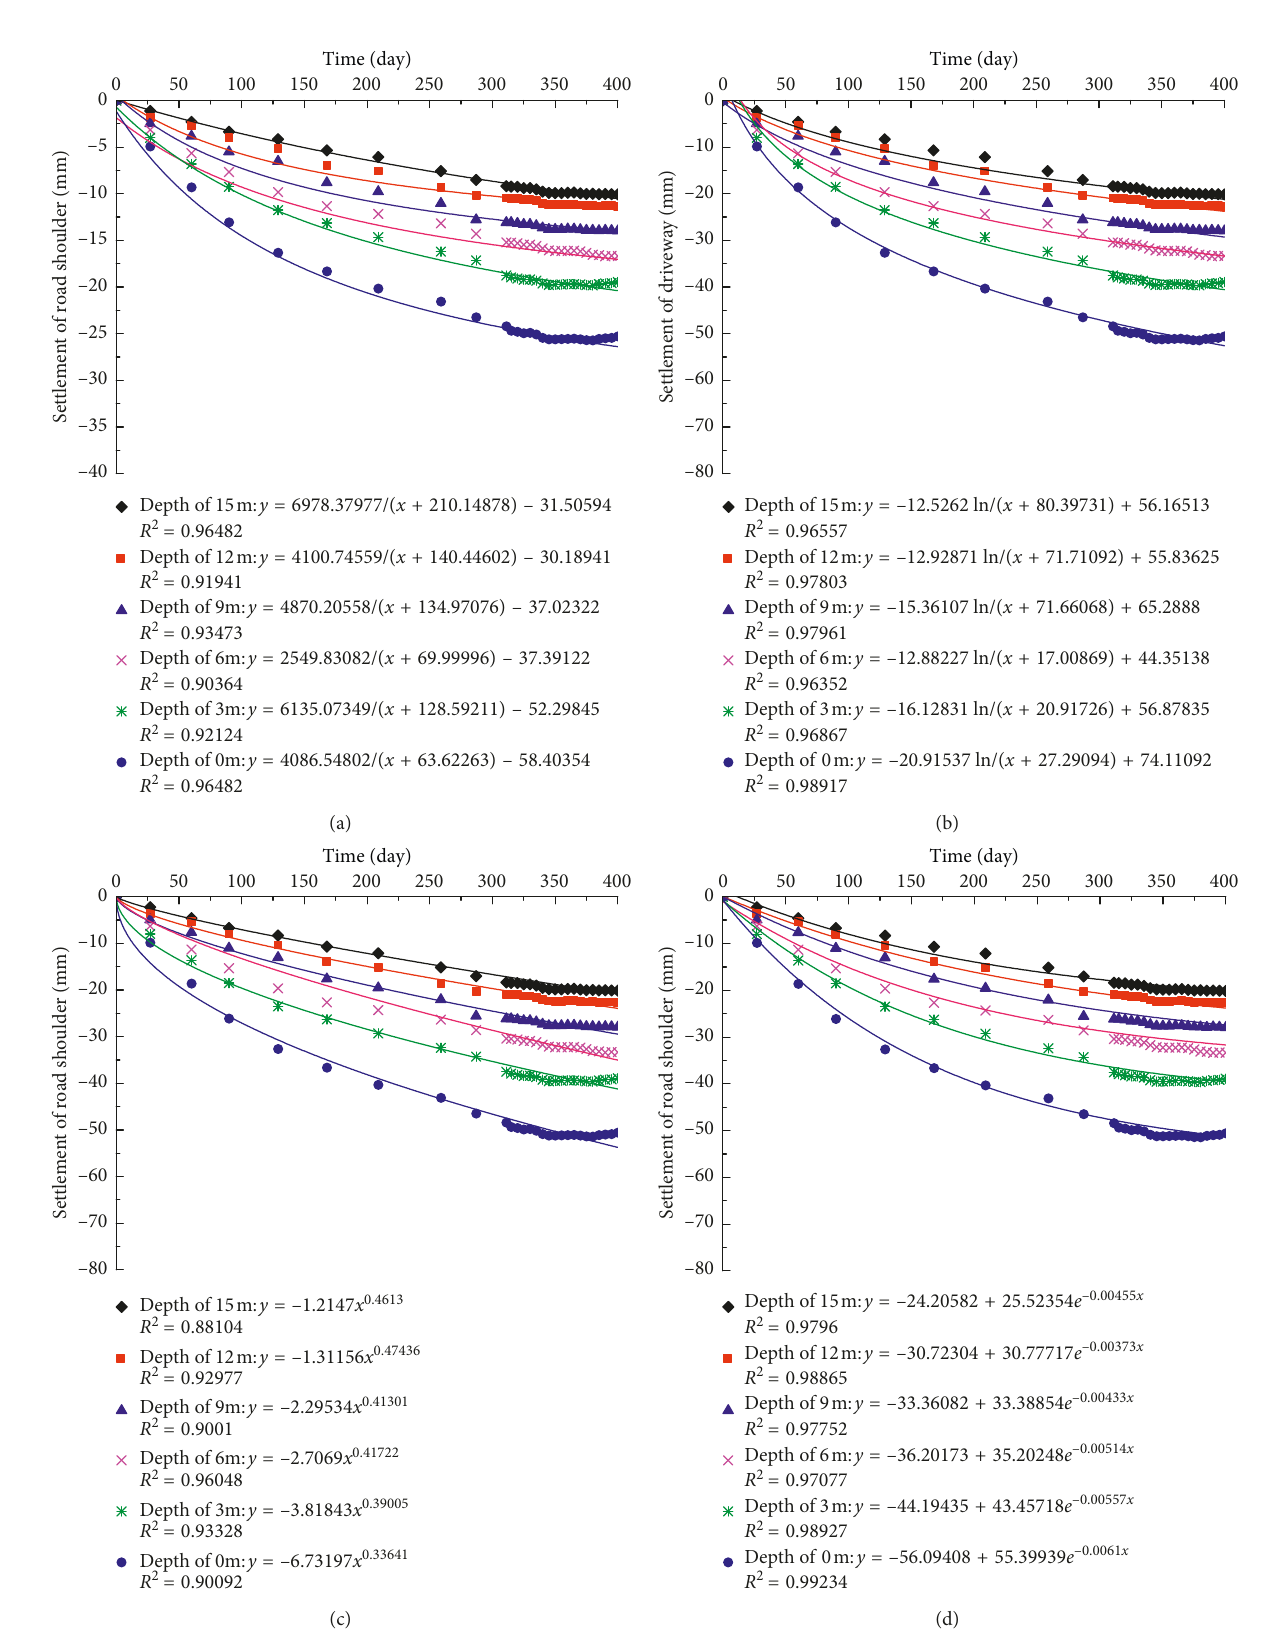
Figure 7: Prediction model for the settlement of the road shoulder: (a) hyperbolic function; (b) logarithmic function; (c) power function; (d) exponential